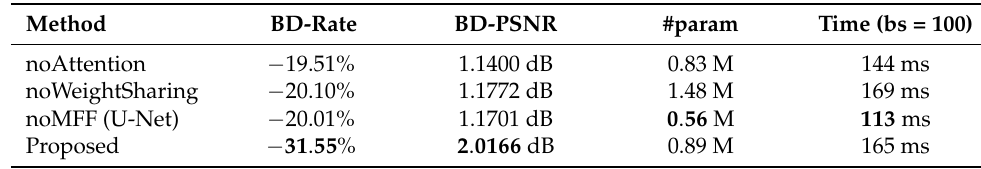
Table 8. Average Bjøntegaard metrics for RGB